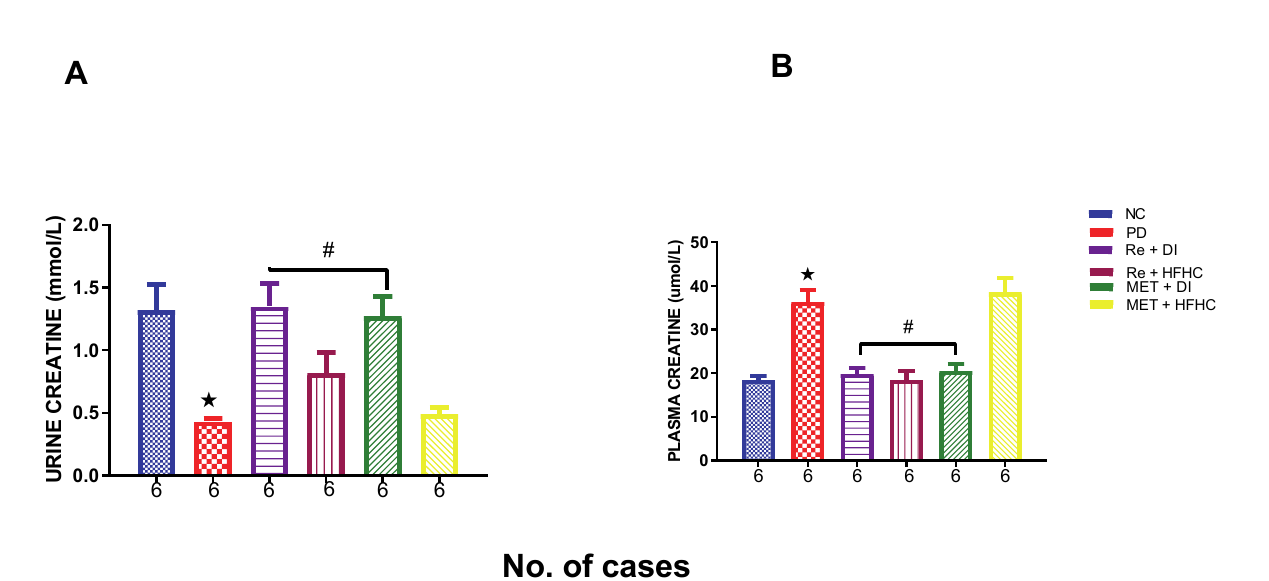
Figure 17. ( A , B ) Urinary and plasma creatinine concentrations in normal control (NC), prediabetic control (PD), metformin and diet intervention (MET + DI), metformin and high-fat/high-carbohydrate diet (MET + HFHC), rhenium (V) compound and diet intervention (Re + DI) and rhenium (V) compound and high-fat/high-carbohydrate diet (Re + HFHC) groups after 12 weeks of treatment. Values are presented as means ± SEM (n = 6). (cid:70) p < 0.05 in comparison with NC; # p < 0.05 in comparison with PC, MET + DI, MET + HFHC, Re + DI and Re +